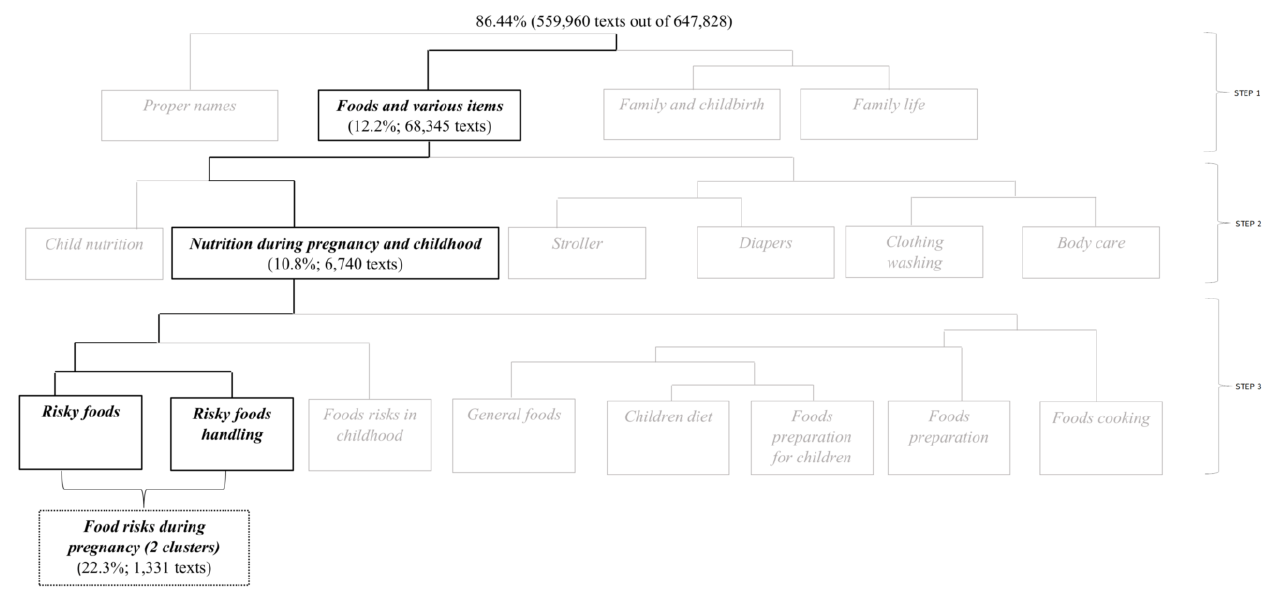
Figure 2. Steps for the selection of the food risks related corpus.